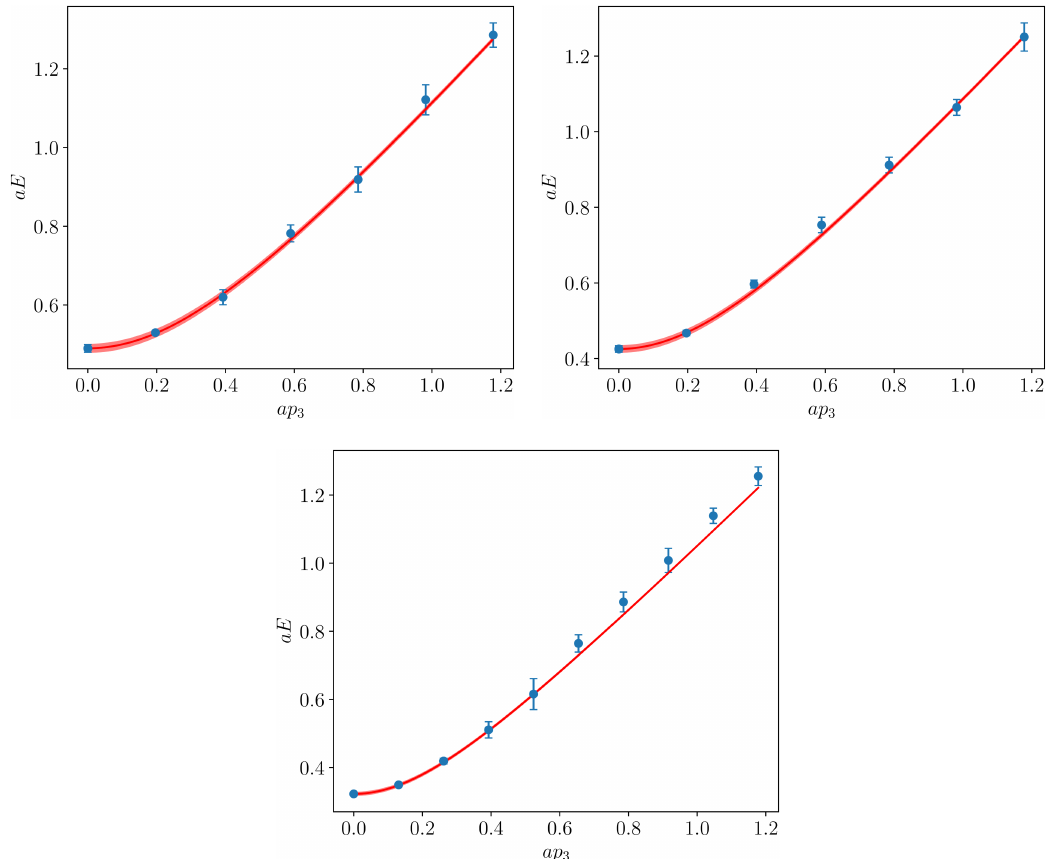
Figure 4 . The results of fitting the effective mass of the principle correlator λ 0 ( T, t 0 ) from the moving states. The ensemble e A 5 , E 5 , and N 5 , are in the upper right, upper left, and bottom respectively. The data points represent the fits to the effective mass and the curve is the continuum dispersion relationship from the rest frame. The energy levels are in agreement with the continuum relationship until the largest momenta where slight deviations